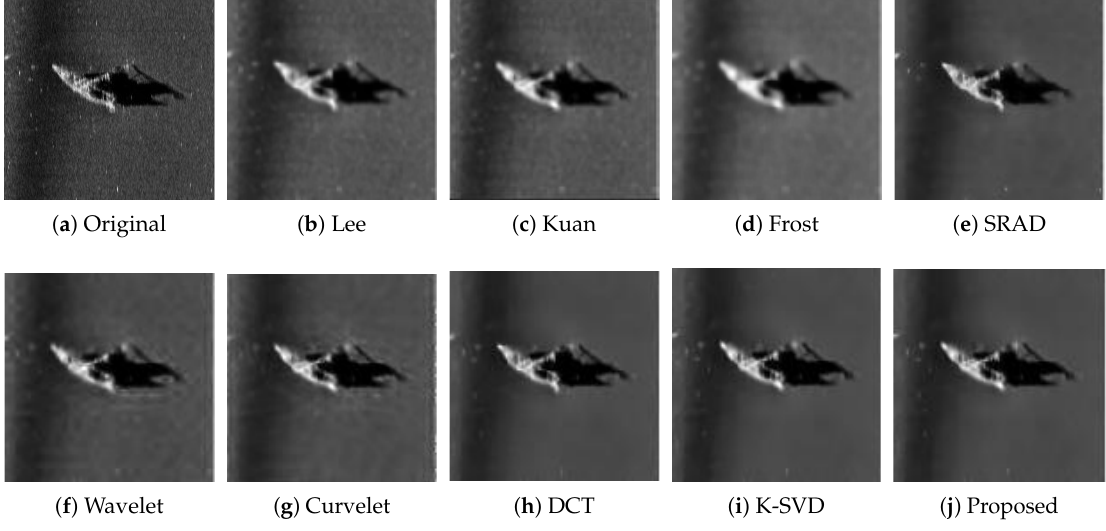
Figure 7. Denoising results of real sonar